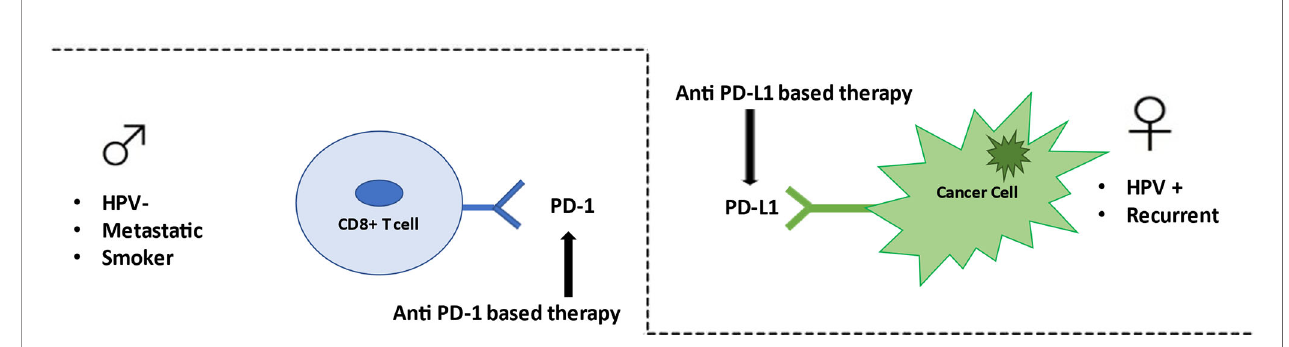
FIGURE 4 | Anti – PD-1/PD-L1 therapy in HN cancer. Anti – PD-1-based therapy appears to be effective in metastatic patients, smoker patients, and HPV-negative patients. Conversely anti – PD-L1-based therapy seems to be better ef fi cient in female patients, in recurrent setting, and in HPV